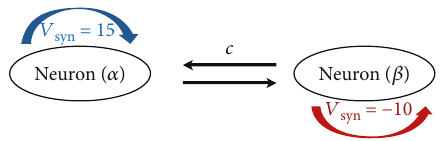
Figure 1: A schematic diagram of the coupled neuron